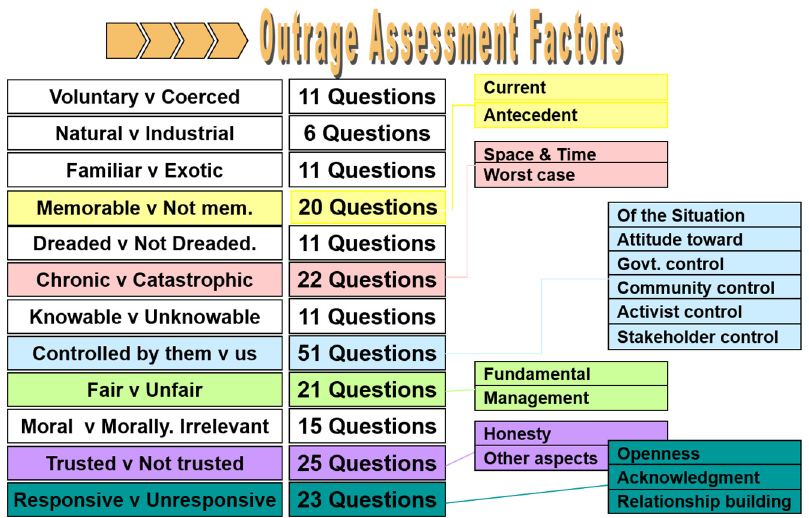
Figure 1. The 12 principal outrage components according to Peter Sandman’s Outrage theory (Available on http://www.psandman.com/handouts/sand58.pdf), and the questions formulated by Sandman in relation to each component. The resulting questions were used to build OPM.